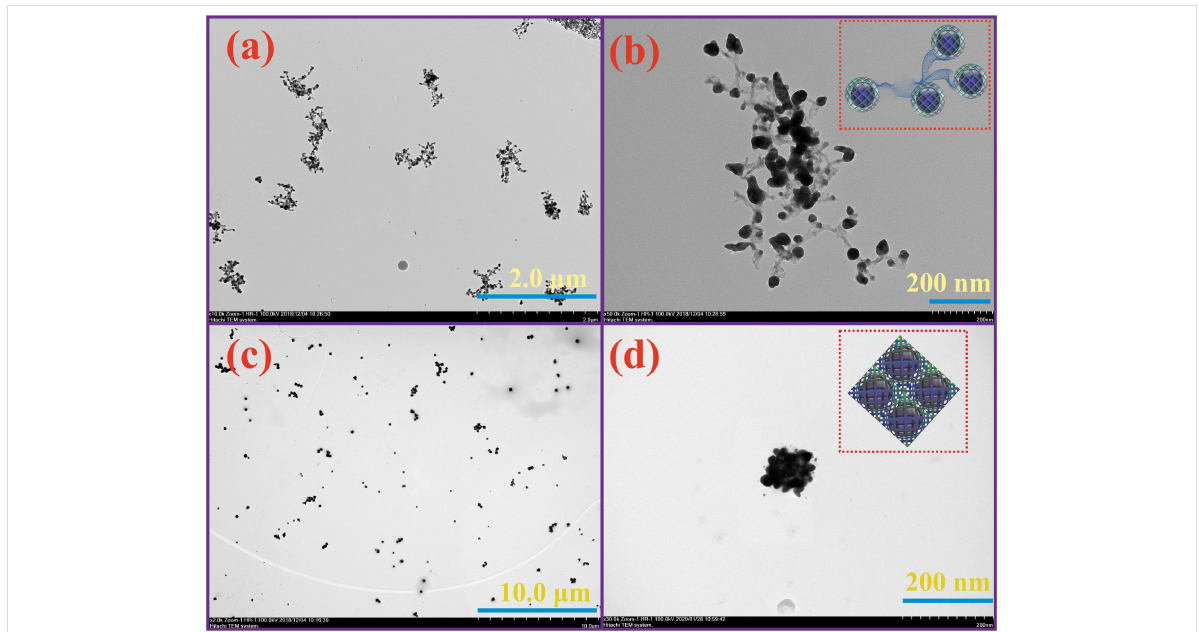
Figure 2: TEM images of pillar[5]arene 3 /Ag + : (a) and (b) 1:1 associates in water (10 − 4 M); (c) and (d) 1:10 associates in water ( c ( 3 ) = 10 − 4 М , c (AgNO 3 ) = 10 − 3 М